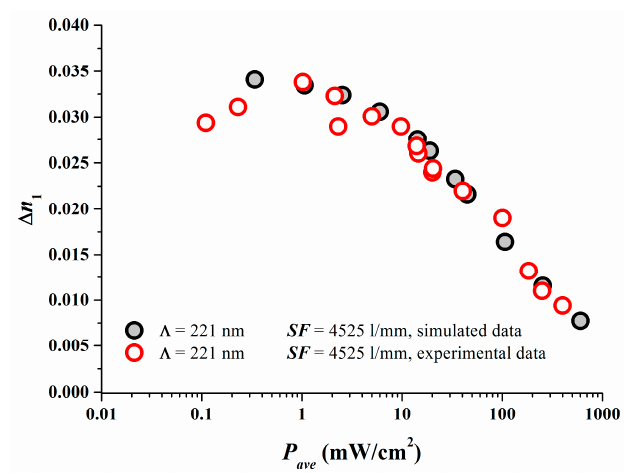
Figure 2. Comparison of the experimental (open symbols) and simulated (filled symbols) mastered power response curve after proper calibration [17].